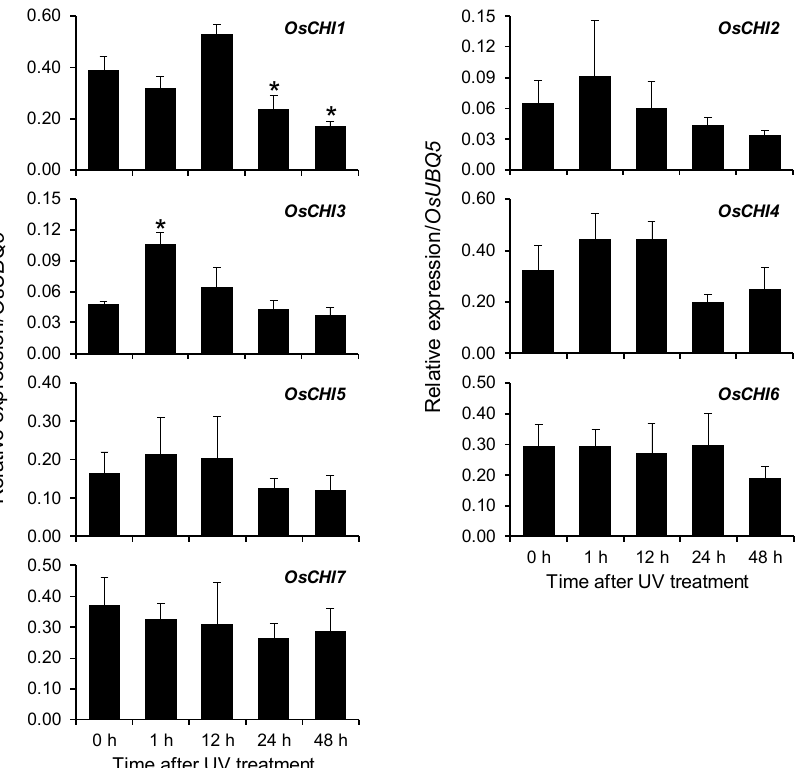
Figure 5. Expression of OsCHI s in rice leaves in response to UV treatment was analyzed using qRT-PCR. Rice plants treated with UV irradiation were collected at the designated time points and used to examine the expression of OsCHI s. A ubiquitin gene ( OsUBQ5 ) was amplified using specific primers and used as an internal control. The expression level of each OsCHI gene was presented as the relative expression compared to the OsUBQ5 mRNA level. Asterisks indicate significant differences ( p < 0.05, t -test) between UV-untreated and UV-treated samples. qRT-PCR analysis was performed on the triplicated biological samples.